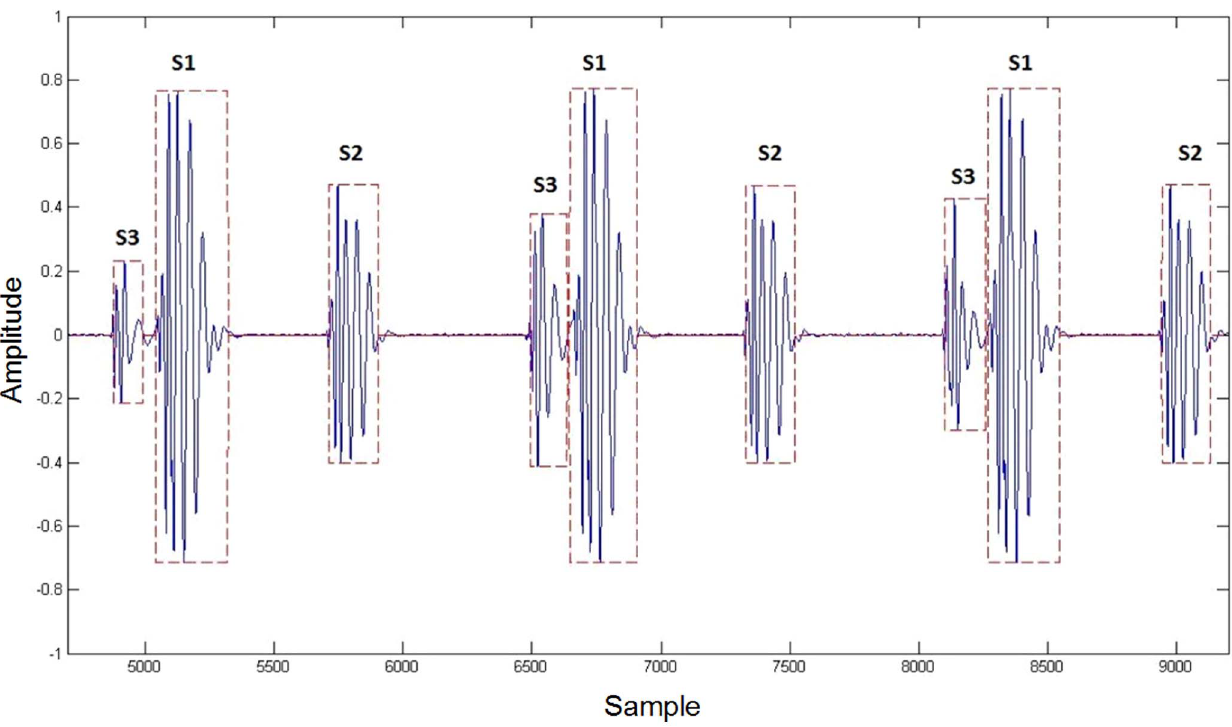
Figure 2. Result of the heart tone segmentation algorithm. The waveform presented contains normal S1, S2 and S3 heart sounds, which are segmented by a variable size time window for further analysis.